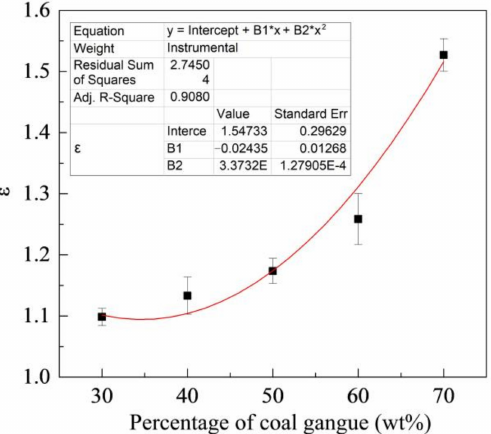
Figure 8. Change of relative wear-resistant coefficient with the percentage of coal gangue.